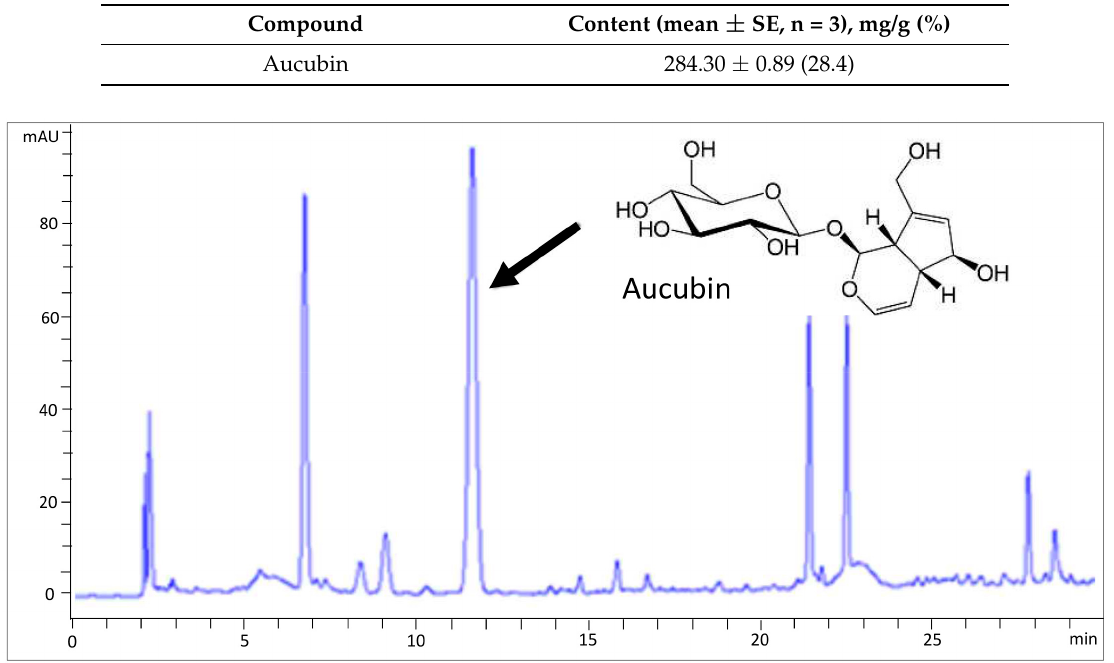
Table 1. Content of aucubin in the Aucuba japonica extract.